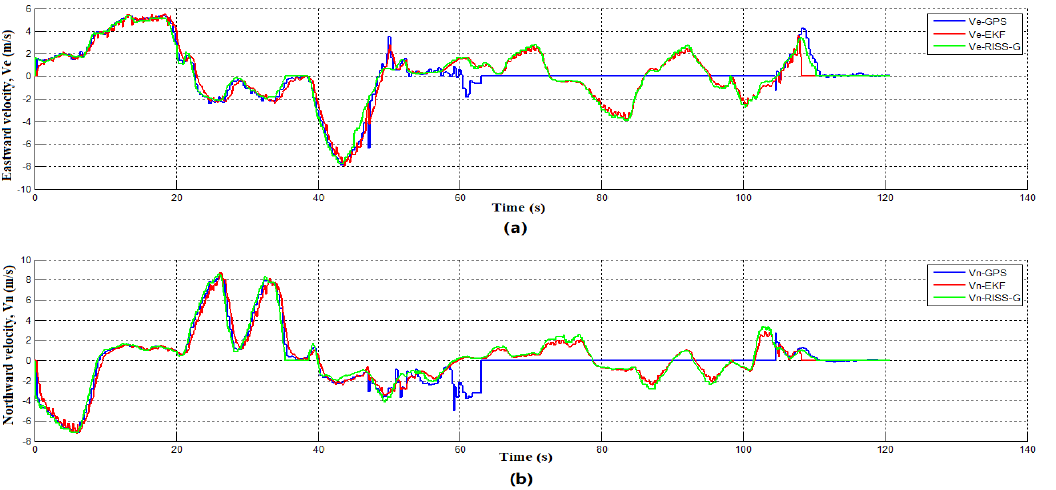
Figure 8. RISS/GPS velocity comparison diagram. ( a ) RISS/GPS eastward velocity comparison diagram; ( b ) RISS/GPS northward velocity comparison